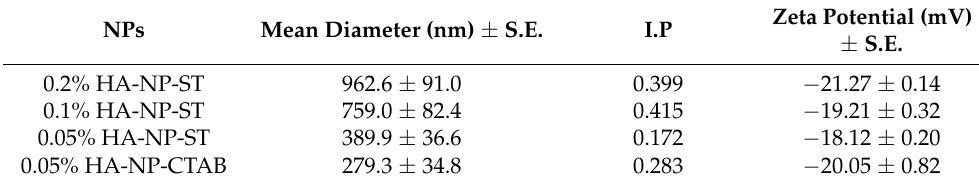
Table 6. Mean diameters and Zeta potentials of HA-NP-ST and HA-NP-CTAB. NPs